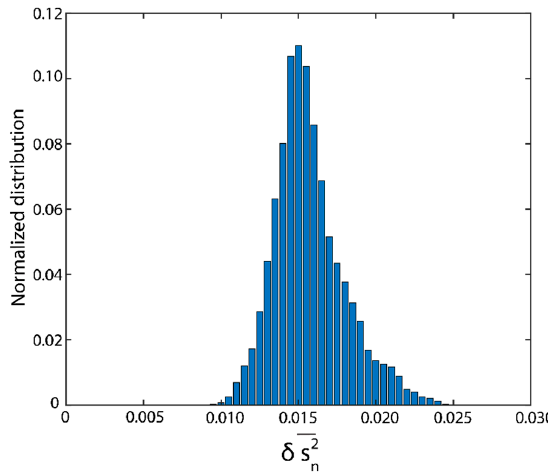
Figure 3. Distribution of δ s 2 n for a region of the South Pacific Ocean admittedly void of high-frequency ocean phenomena such as ISWs or sharp ocean fronts (see text for details).